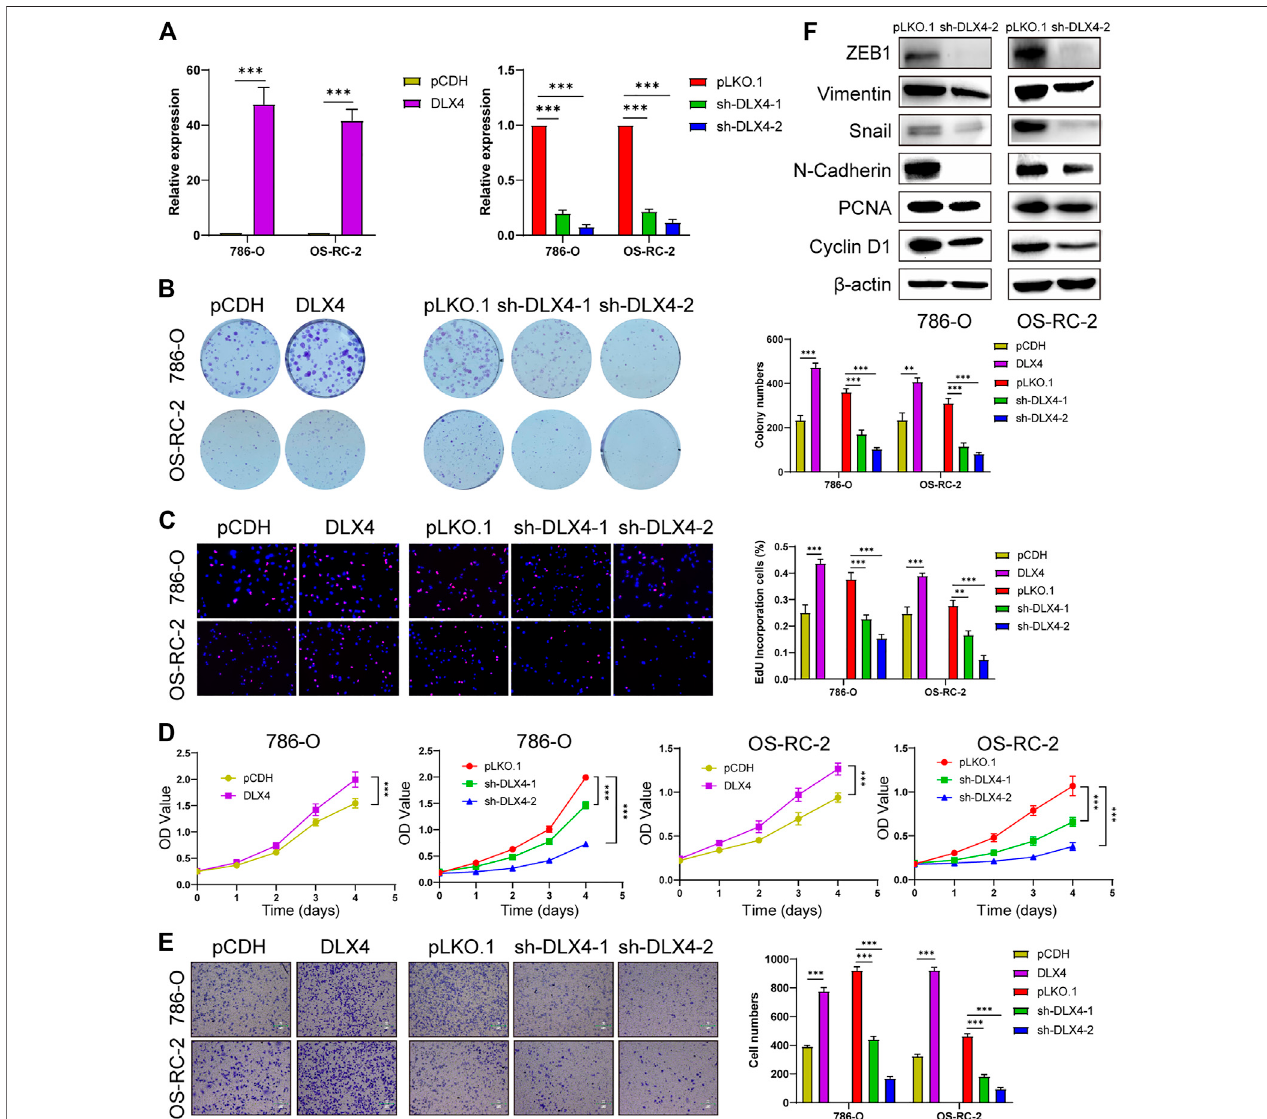
FIGURE 7 | DLX4 promotes cell proliferation and migration of ccRCC. (A) The ef fi ciency of RCC cell lines stably overexpressing or knocking down DLX4 was veri fi ed by RT-PCR. (B – D) Colony formation assays, EdU assays, and CCK-8 assays were performed in ccRCC cell lines. (E) Transwell migration assay was applied in ccRCC cell lines. (F) The knockdown of DLX4 downregulates the expression of proliferation and EMT-related proteins.